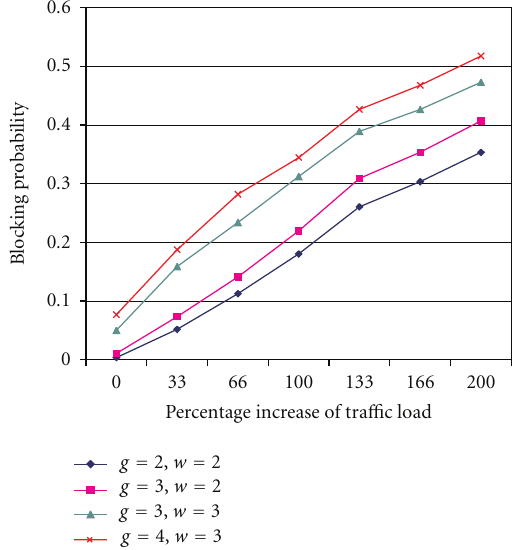
Figure 6: Comparison of performances of ILP2 with di ff erent combinations of values of W 1 , W 2 , and W 3 , for ratio 35 :35 with g = 4 and w = 3.